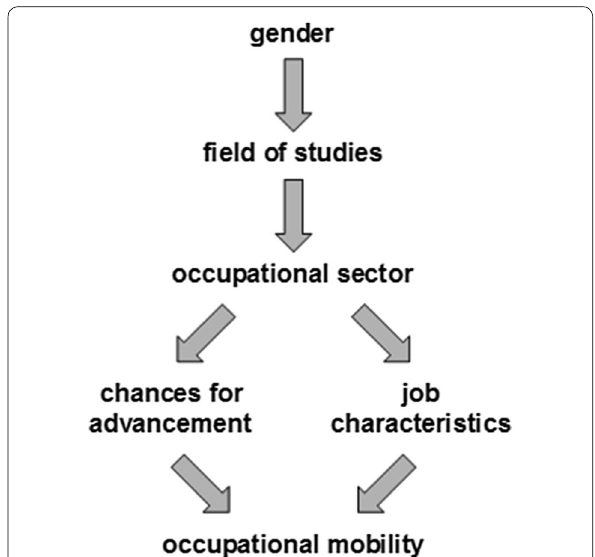
Fig. 1 Assumed relationships ( Source Author; created with LibreOf- fice Draw